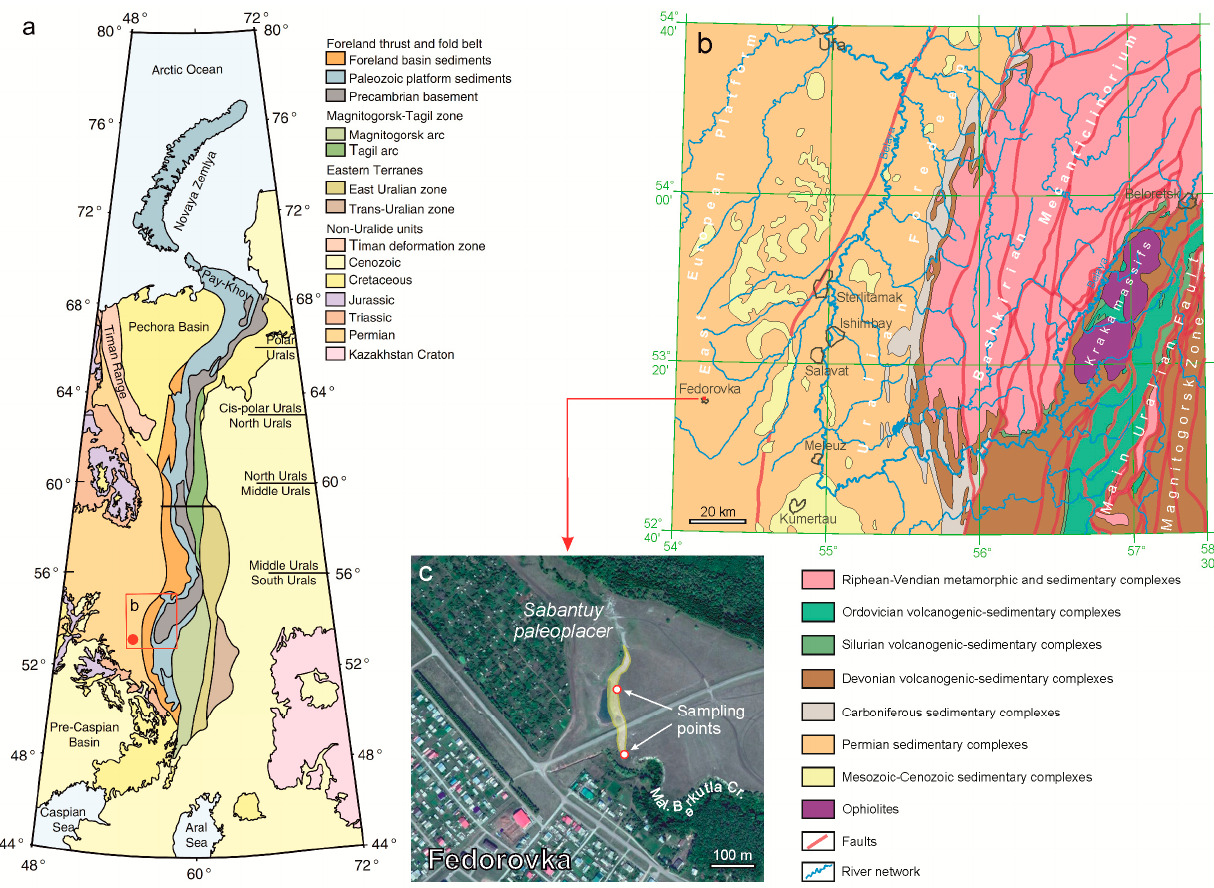
Figure 1. Structural zones of the Uralides [23] ( a ) with the position of Sabantuy placer close to Fedorovka village (red rectangle) corresponding the fragment of the State geological map N-40 (Ufa) simplified after Knyazev with co-authors [38] ( b ). The Sabantuy paleoplacer locality on a satellite image ( c ).